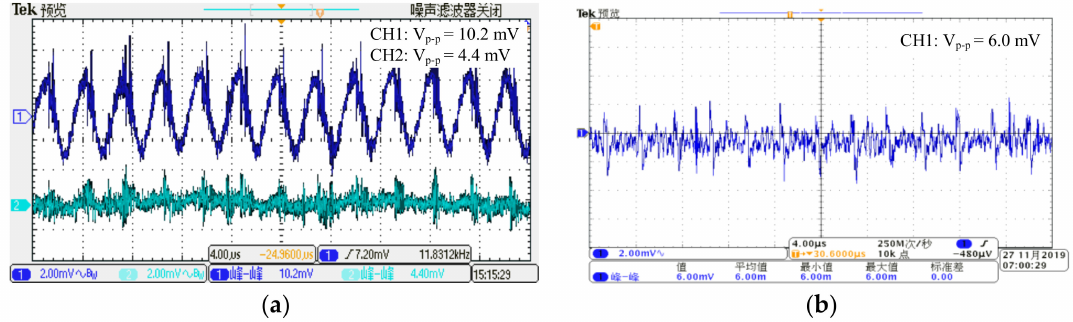
Figure 8. The noise diagram of the charge amplifier: ( a ) the comparison diagram of the power module after filtered; ( b ) the noise of the charger